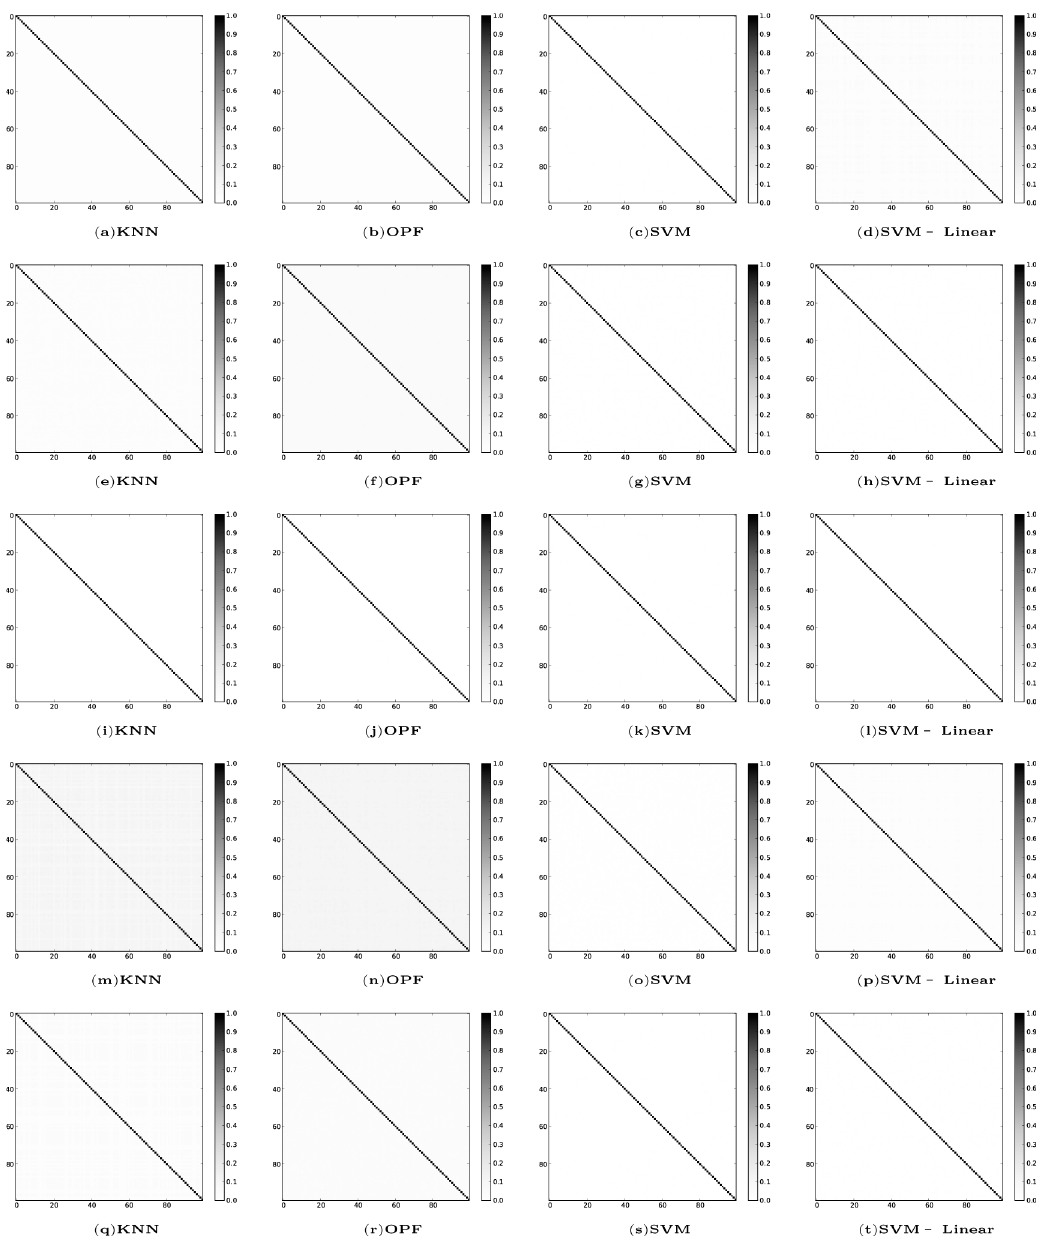
Fig 2. Correlation table between each pair of training sets, Z 1 , after the learning process with learning constraint of 300 seconds. Cod-RNA (a — d). Connect (e — h). Covertype (i — l). IJCNN (m — p). SensIT (q — t).